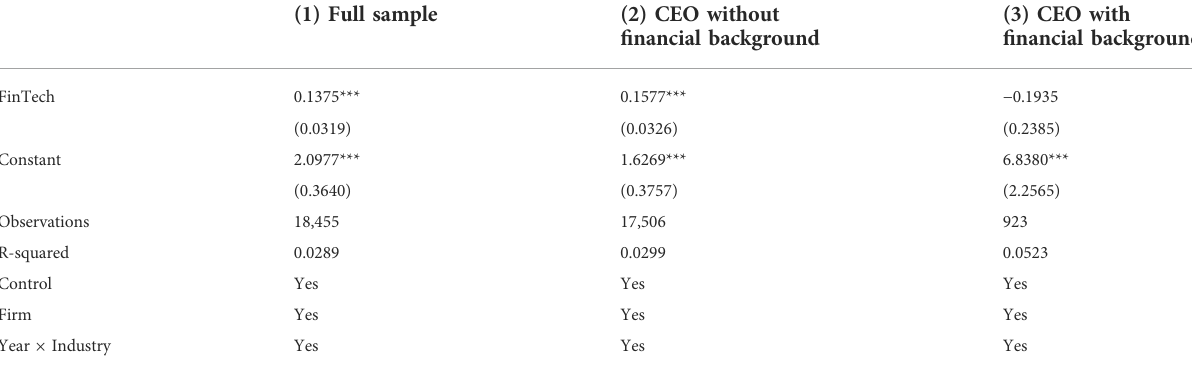
TABLE 11 Further tests based on the CEO ’ s fi nancial